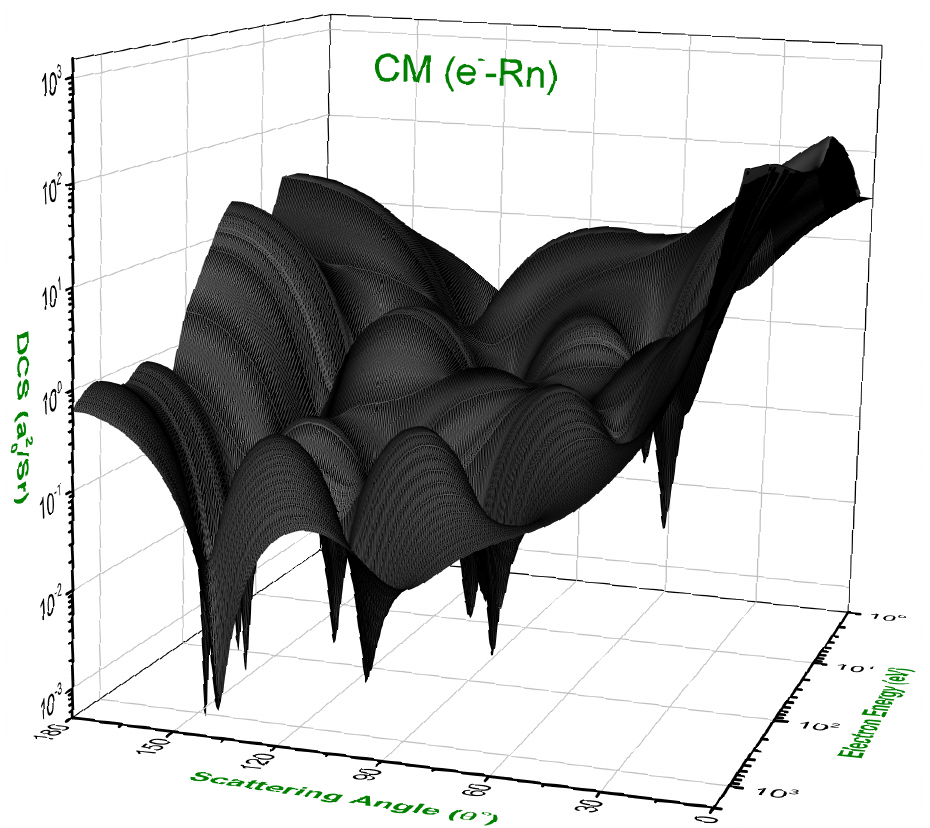
Figure 16. A three dimensional plot of the present DCS for electrons elastically scattered from neutral radon